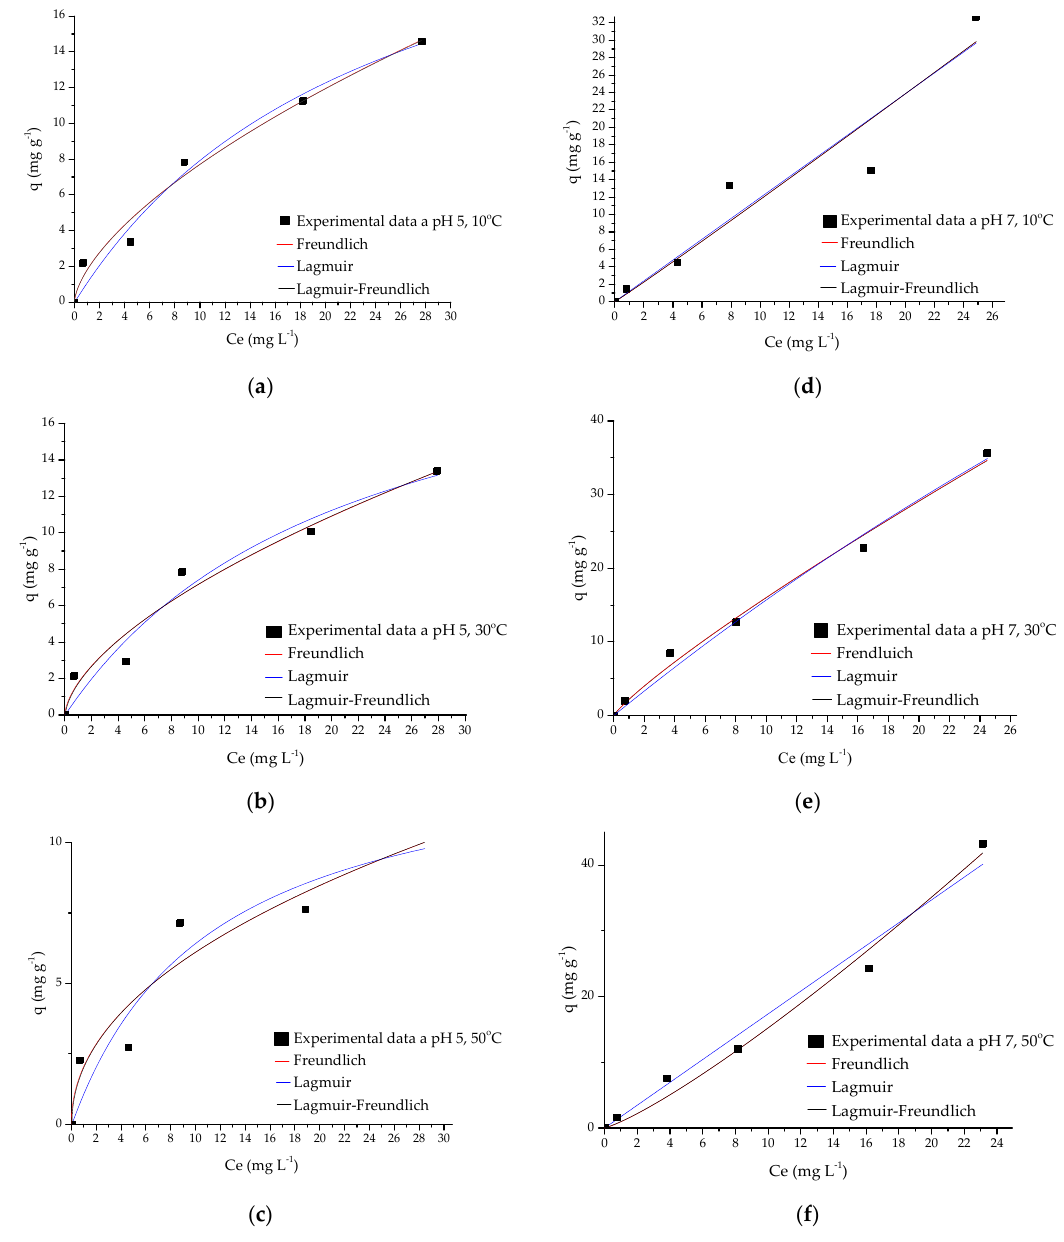
Figure 5. Adsorption isotherm ( a ) Ch-PVA-NaOH-TPP (pH 5, T = 10 °C); ( b ) Ch-PVA-NaOH-TPP (pH 5, T = 30 °C); ( c ) Ch-PVA-NaOH-TPP (pH 5, T = 50 °C); ( d ) Ch-PVA-NaOH-TPP (pH 7, T = 10 °C); ( e ) Ch-PVA-NaOH-TPP (pH 7, T = 30 °C) and ( f ) Ch-PVA-NaOH-TPP (pH 7, T = 50 °C).